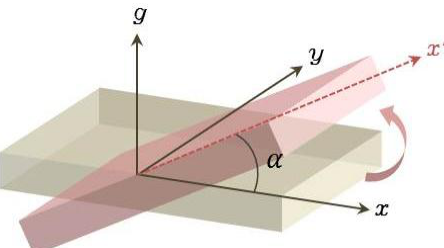
Figure 1. X-axis tilt assignment relative to the